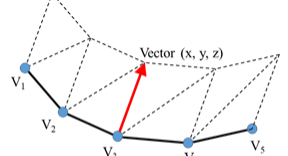
Figure 14. Same normal vectors of planes.